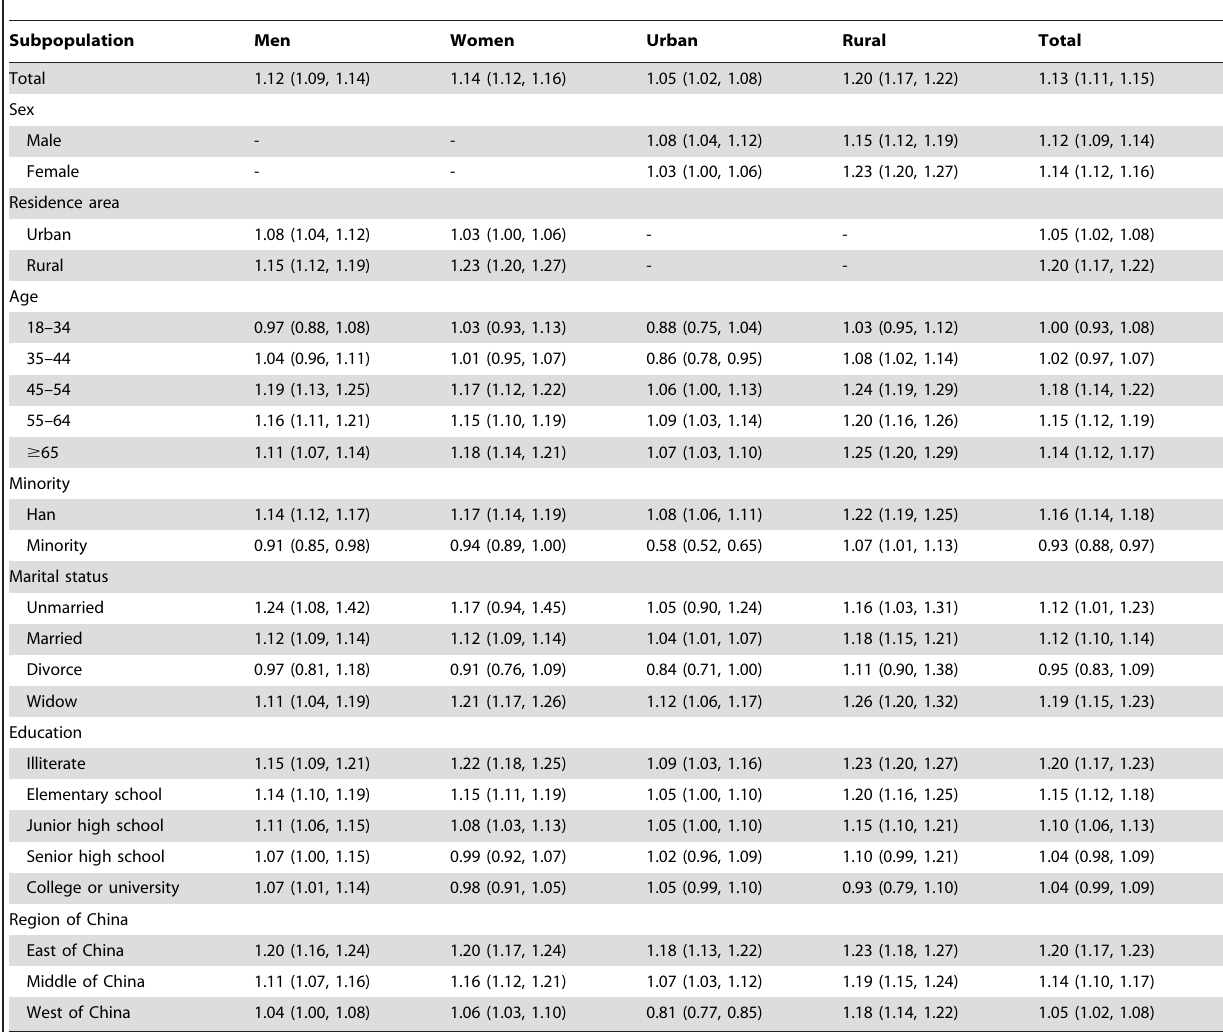
Table 4. Adjusted RR and 95%CI for 2008 vs. 2003 in chronic disease in the last 6 months in different